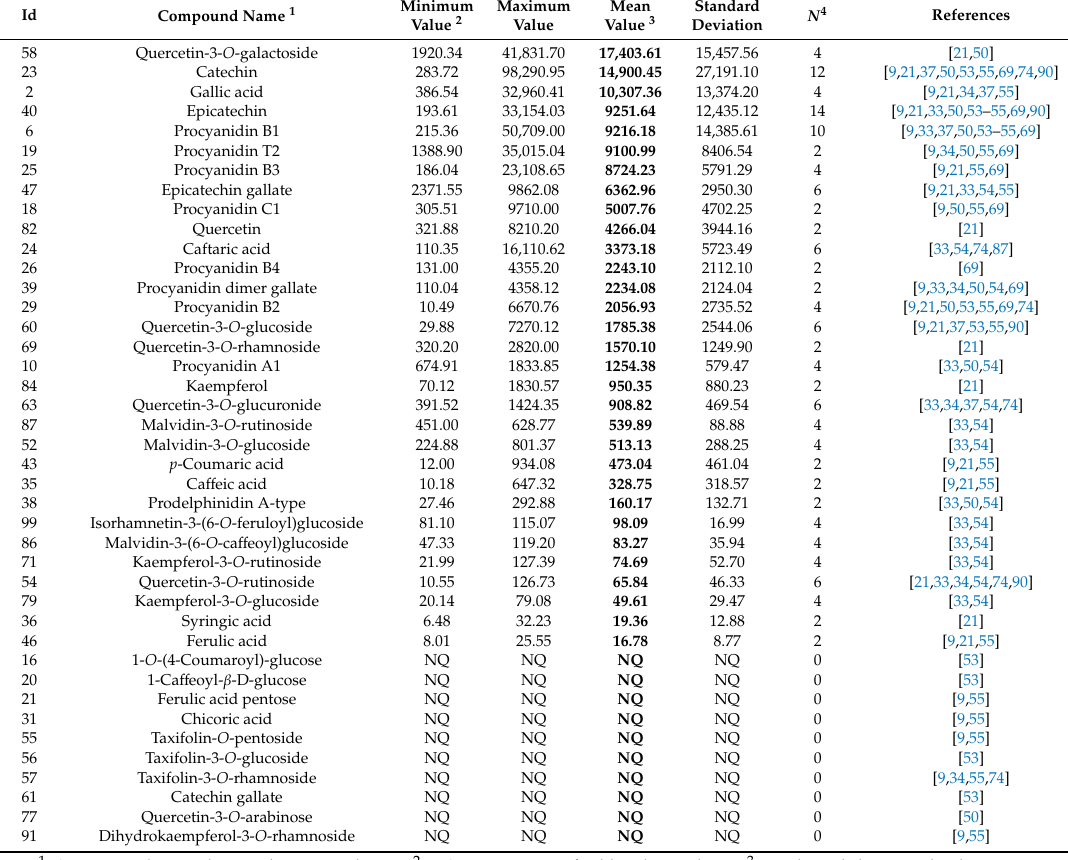
Table 5. Levels (mg / kg) of 41 polyphenols (excluding stilbenes) identified in grapevine